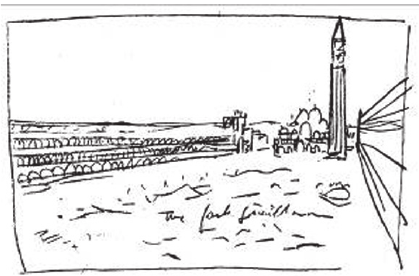
fig. 3. San Marco square in Venice. from le Corbusier 1946,